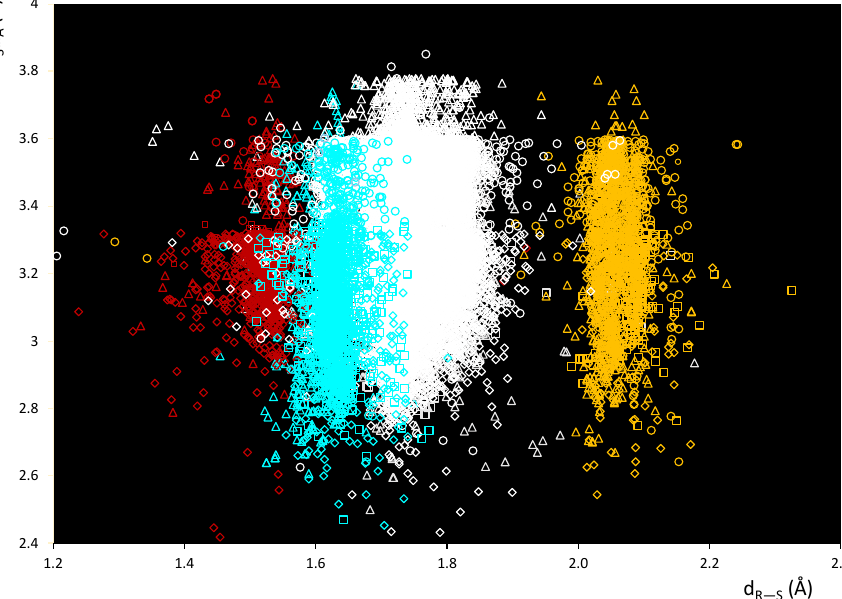
Figure 2. Scatterplot of d S···A vs. d R – S distances within fragments R – S···A. R = C (white), O (red), N (cyan), and S (yellow); A = N (square), Ch (circle), O (rhomb), and Ha (triangle). The bond distances d R – S and ChB interaction distances d S···A were used to calculate the the values calculated for all R – S···A fragments is shown in Figure 3.